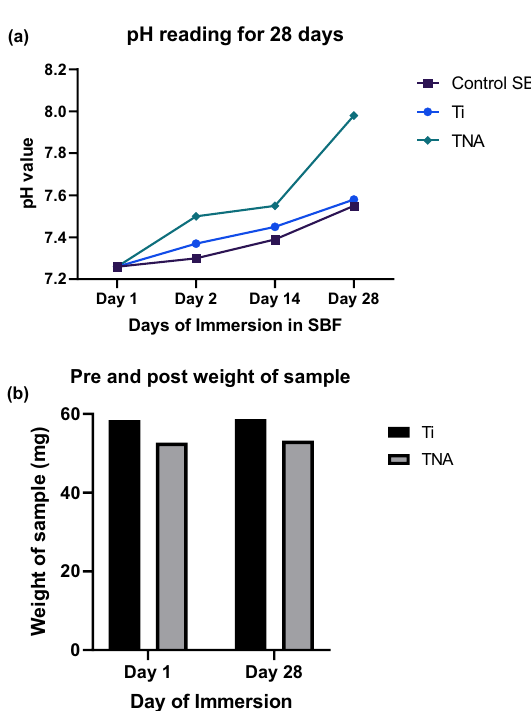
Fig. 1 Apatite formation ability for 28 days profiles on Ti and TNA using SBF model. a pH reading from day 1 to day 28 profile. b Pre & post-weight changes on day 1 and day 28